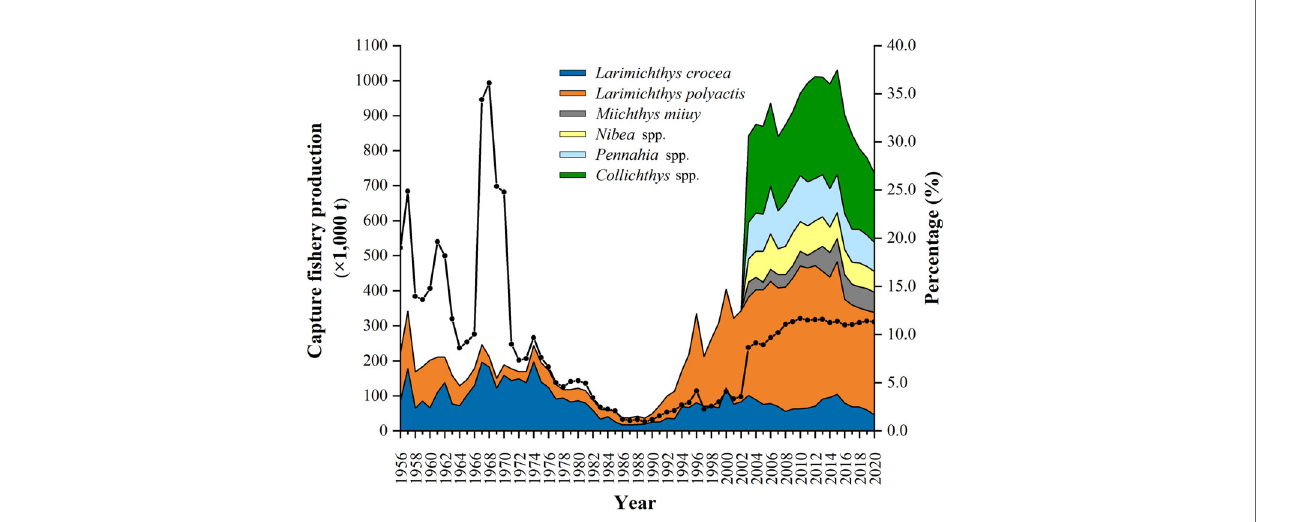
FIGURE 1 | The estimated statistical annual sciaenid (three at species level and three at genus level) capture fi shery productions (× 1,000 t) between 1956 and 2020 in China, together with their contributions (percentage, %) (solid line) to the annual total marine fi sh capture productions (MOA, 1950 – 2018; MARA, 2019 –